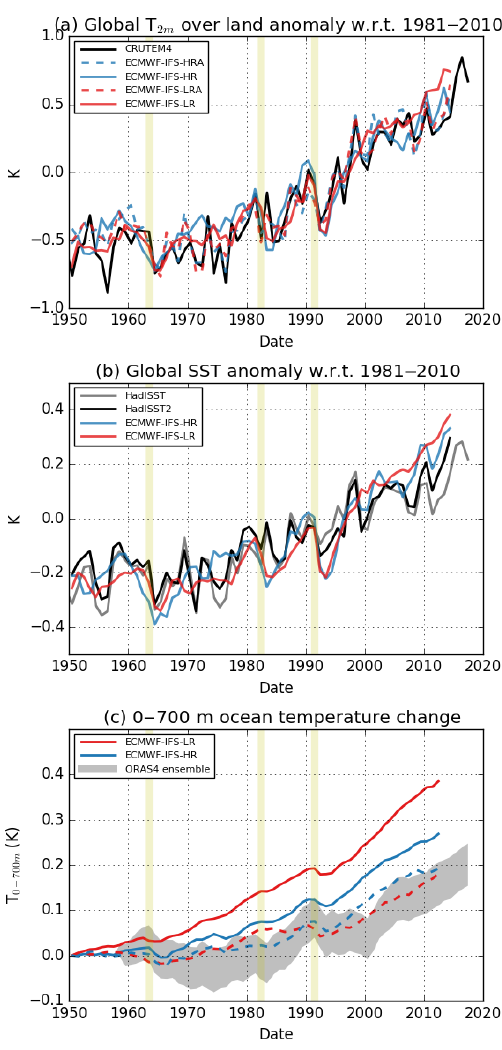
Figure 1. (a) Global mean 2m temperature over land ( T 2m ) from ensemble means of the hist-1950 and highresSST-present experi- ments and the CRUTEM4 observational data set (Jones et al., 2012; Osborn and Jones, 2014). (b) Global mean sea surface temperature (SST) from ensemble means of the hist-1950 experiment and the Hadley Centre Sea Ice and Sea Surface Temperature (HadISST) (Rayner et al., 2003) and HadISST2 observational data sets (Rayner et al., 2016; Titchner and Rayner, 2014). (c) Volume-averaged ocean temperature (0–700m) change relative to the first year of data in individual ensemble members of the hist-1950 experiment and the ORAS4 ensemble of ocean reanalyses (Balmaseda et al., 2013). Dashed lines are estimates of temperature change in hist-1950 after adjusting for long-term drift in the ocean by calculating temperature change relative to the corresponding control-1950 experiments. In all plots, periods corresponding to the Mount Pinatubo (1991), El Chichón (1982), and Mount Agung (1963) volcanic eruptions are shaded in yellow. All data points represent annual mean